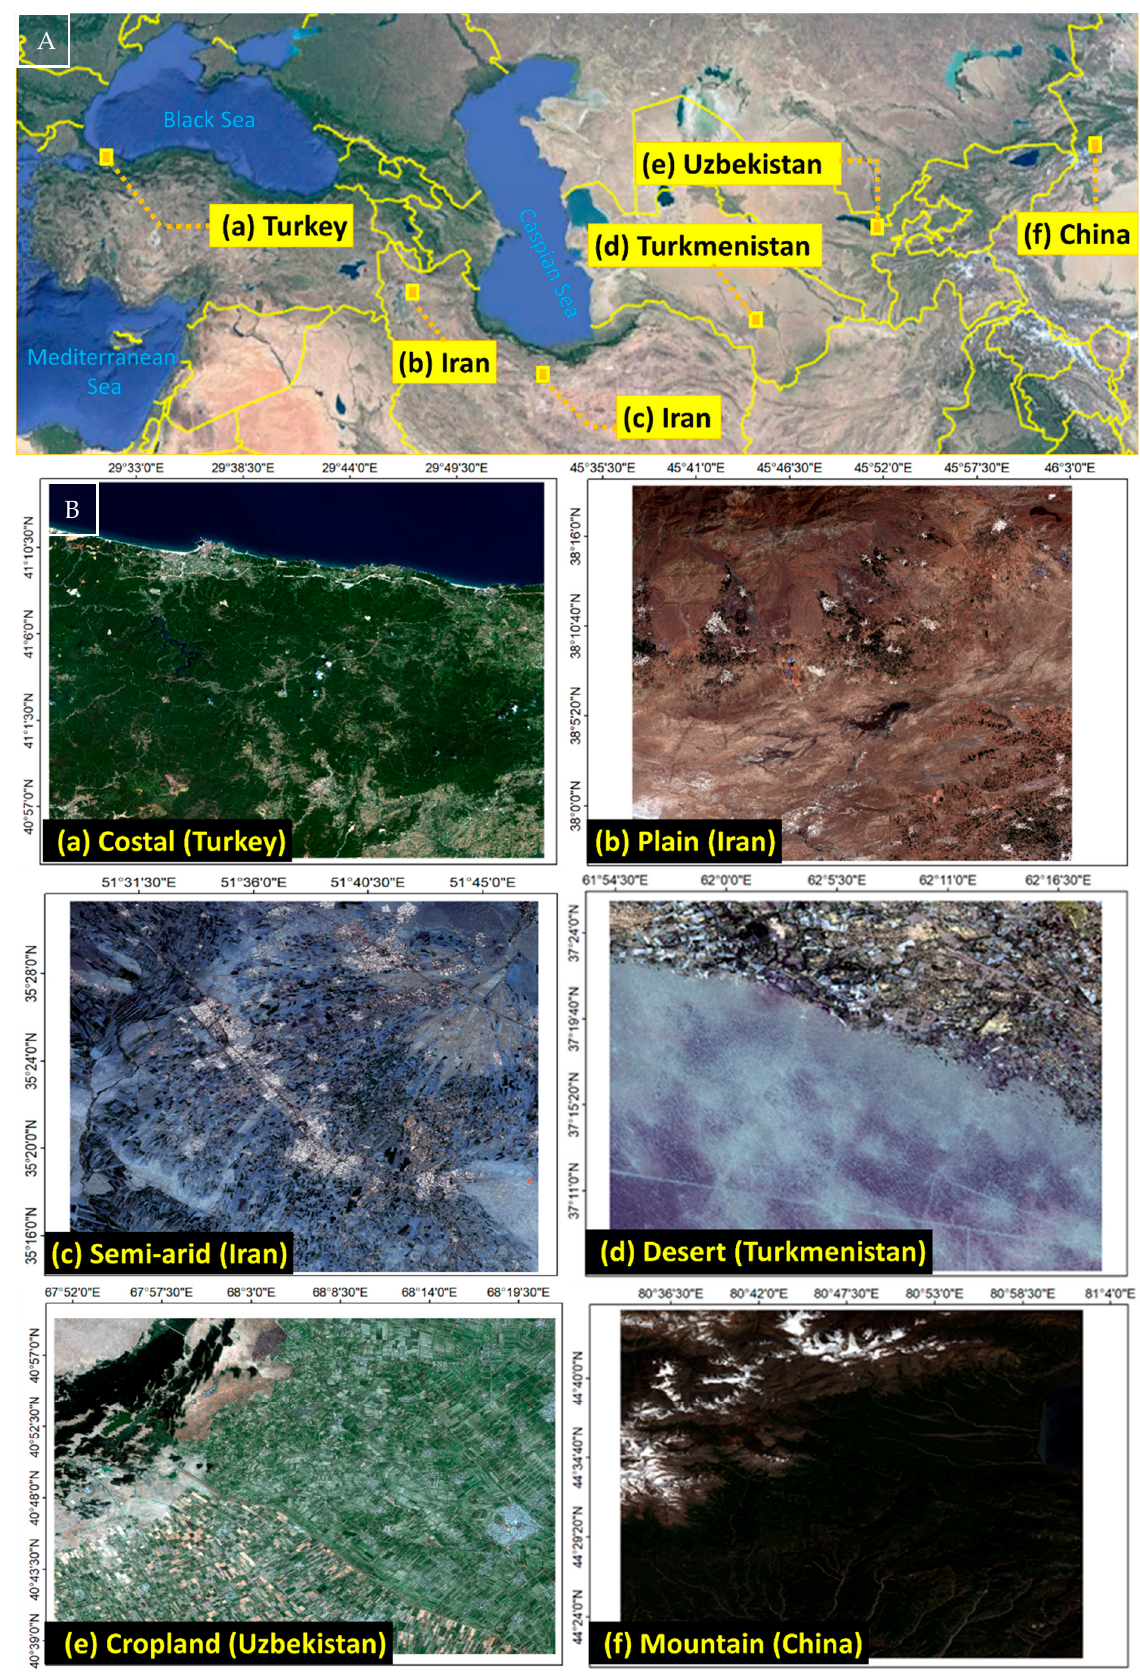
Commented [M1]: We added subfigure name (A) and (B) in the picture, please confirm.